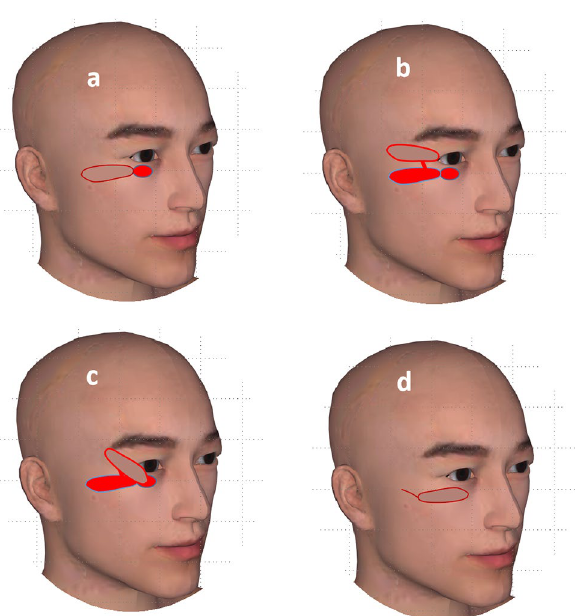
Figure 1. The schematic diagram of the operation. ( a ) The subcutaneous pedicled propeller flap was designed according to the eyelid defect. ( b ) The subcutaneous pedicled propeller flap was cut. ( c ) The flap was rotated for 180° to cover the defect. ( d ) The flap was sutured to the defect, and the donor site was also